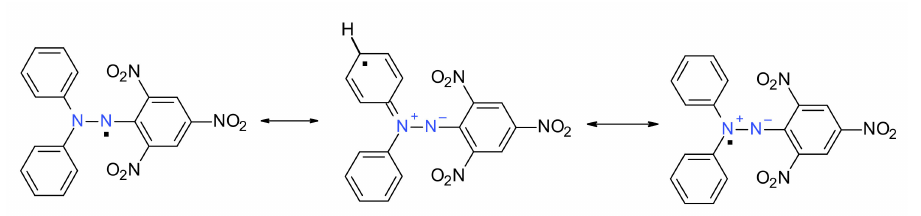
Figure 2. Some resonance structures of DPPH · free radical.